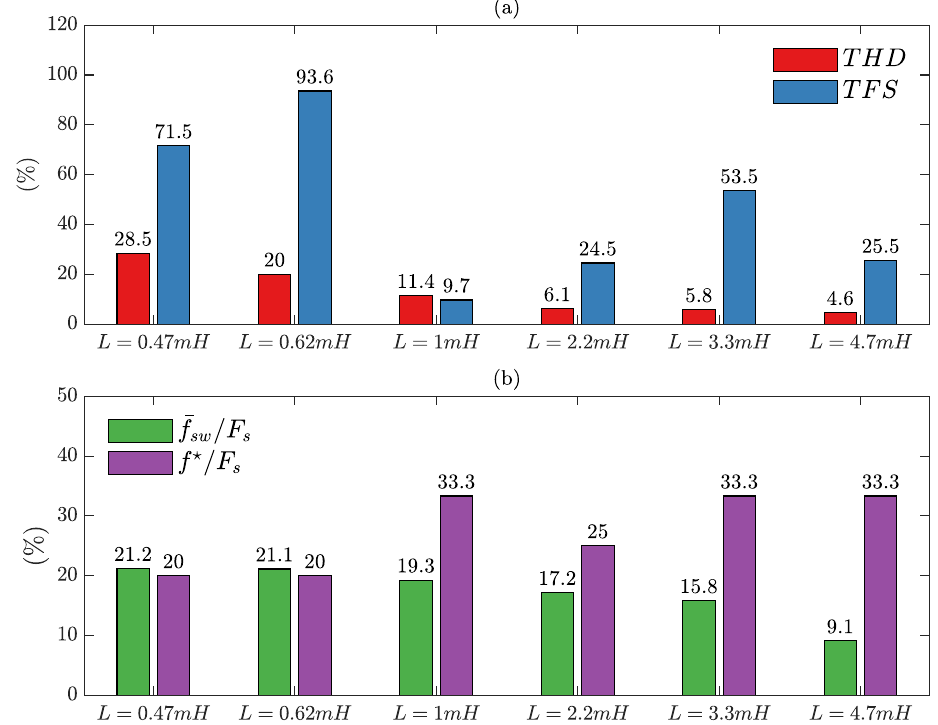
Figure 10. Filter sizing effect in FCS-MPC using the cost function (11): ( a ) THD and TFS and; ( b ) ¯ f sw and f (cid:63) sw .